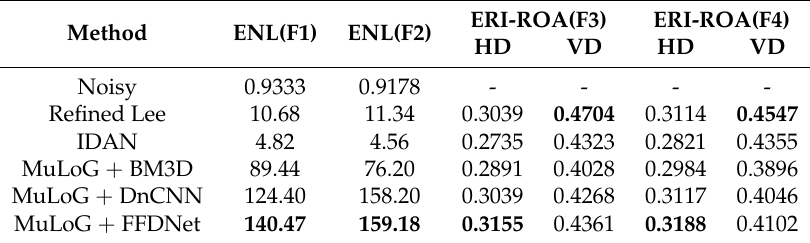
Table 8. The quantitative comparison of different methods for